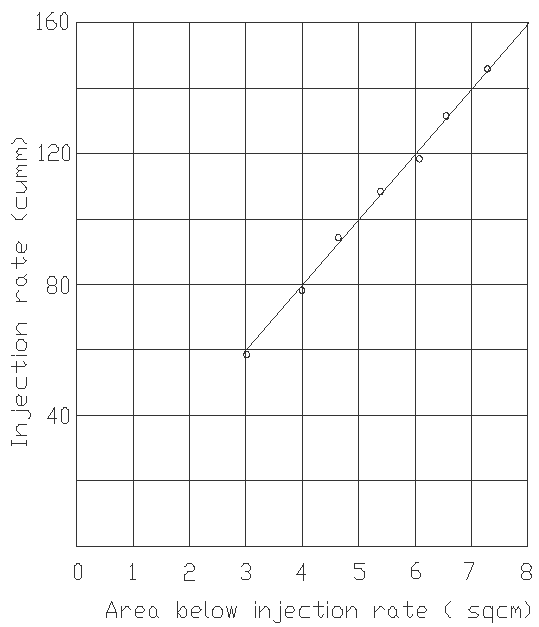
Figure 6. Linearity chart for total injection rate.